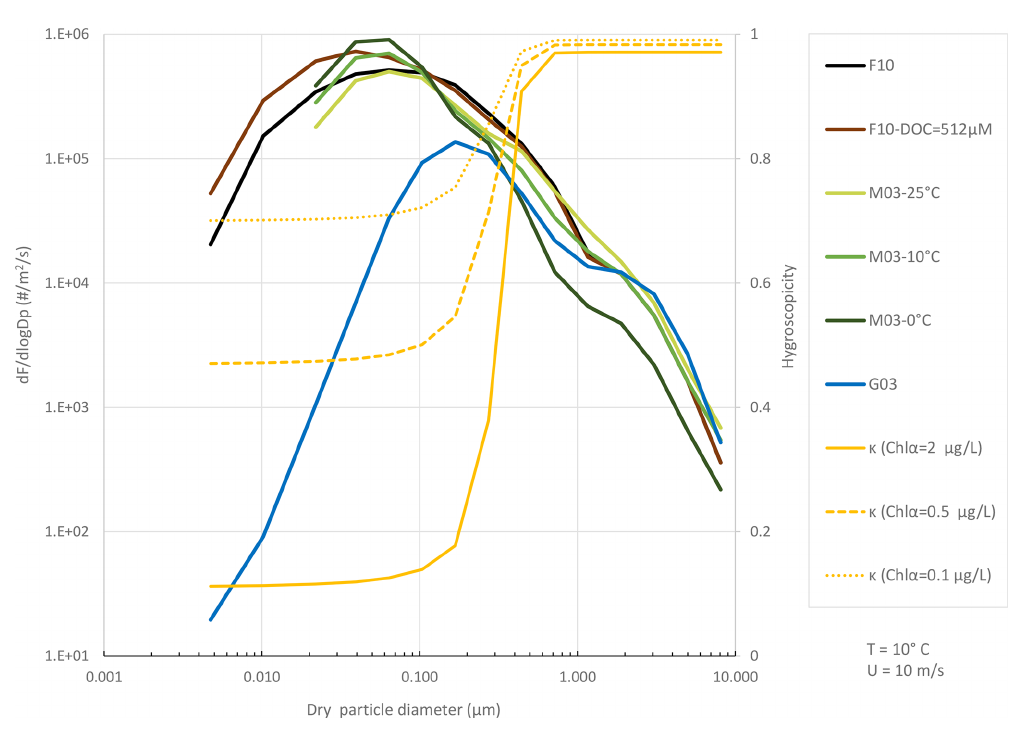
Figure 1. Sea spray flux from different parameterizations and hygroscopicity parameter kappa, derived based on the size-dependent organic fraction for different chlorophyll a concentrations in sea water. Fluxes are shown for pure sea salt. Kappa values of 1 and 0.1 are assumed for the sea salt and the organics,